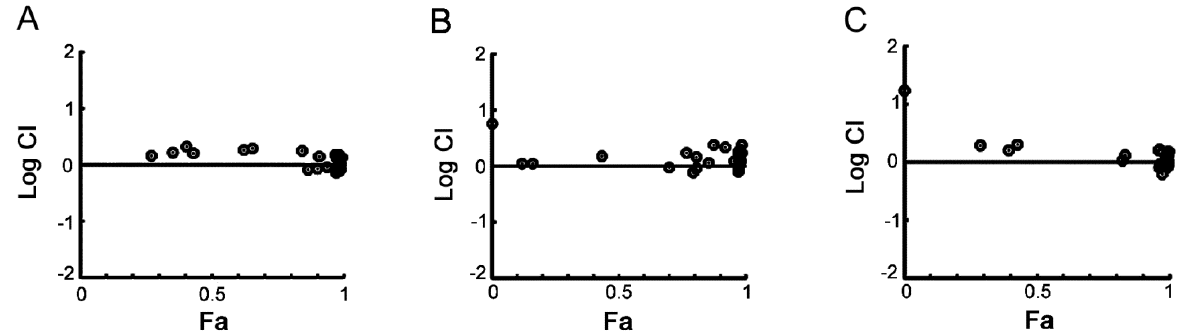
Figure S2. Sequential combination analysis of PHA-767491 with drugs constituting standard of care. MM1S cells were treated with Melphalan (Range 2 to 32 µM, A ) Doxorubicin (Range 31 to 500 nM, B ) Bortezomib (Range 1.3 to 20 nM, C ) for 3 h followed by treatment with PHA-767491 in a non-constant ratio. Cell viability was examined by CellTiter Glo 48 h after drug treatment. Combination indices (CI) were calculated and the Log CI (circles) plotted in relation to the fraction of cells affected (Fa) at any given experimental